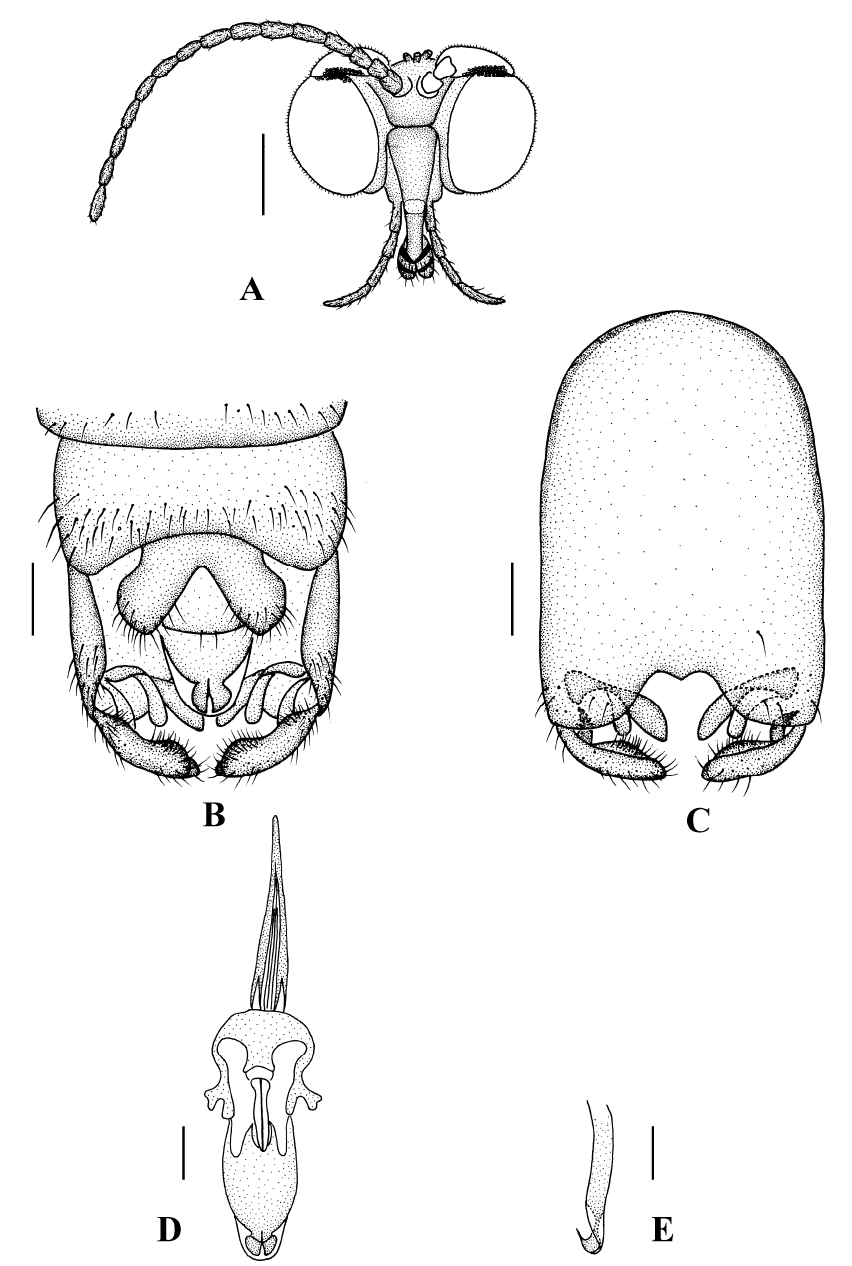
Figure 6. Blepharicera dushanzica sp. nov. (male holotype). ( A ) male head, frontal view ( B ) male genitalia, dorsal view ( C ) male genitalia, ventral view ( D ) aedegal complex, dorsal view ( E ) tip of dorsal paramere, lateral view. Scale bars: 0.25 mm ( A ), 0.1 mm ( B – E ). Thorax (Figure 5B). Pronotum and propleuron brown without hairs. Mesonotum brownish black with a brownish yellow median stripe at posterior 1/2; scutellum brown with numerous hairs grouped at the posterolateral corner; metanotum brown; episternum brown; epimeron yellow. The relative length of the femur, tibiae, and 1st to 5th tarsomeres in the fore leg as 15:10.5:7.8:3.6:2.2:1:1, in the mid-leg as 13.8:10.5:6.2:2.7:1.8:1:1, in the hind leg as 15.5:12.7:5:1.2:1:0.8:1. Fore coxa pale with basal 1/2 light brown, with light brown hairs; mid coxa with an appendage, pale with brownish black hairs; hind coxa pale with brownish black hairs; trochanters pale, anterior margin with black spot apically, with brownish-black hairs; femora pale basally and gradually darkened to brown apically, with brownish-black hairs; tibiae brown with brownish black hairs; tarsomeres brown